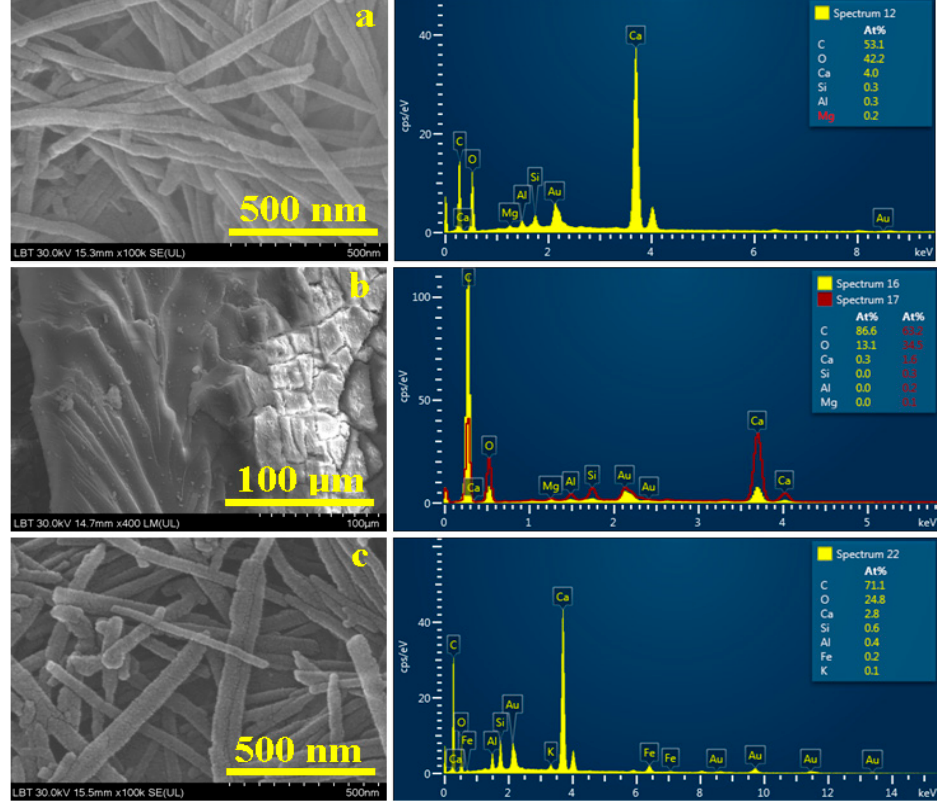
Figure 8. SEM images and EDS spectra obtained for the organic fractions within the amphora sediments: ( a ) Sample1, ( b ) Sample 2 and ( c ) Sample